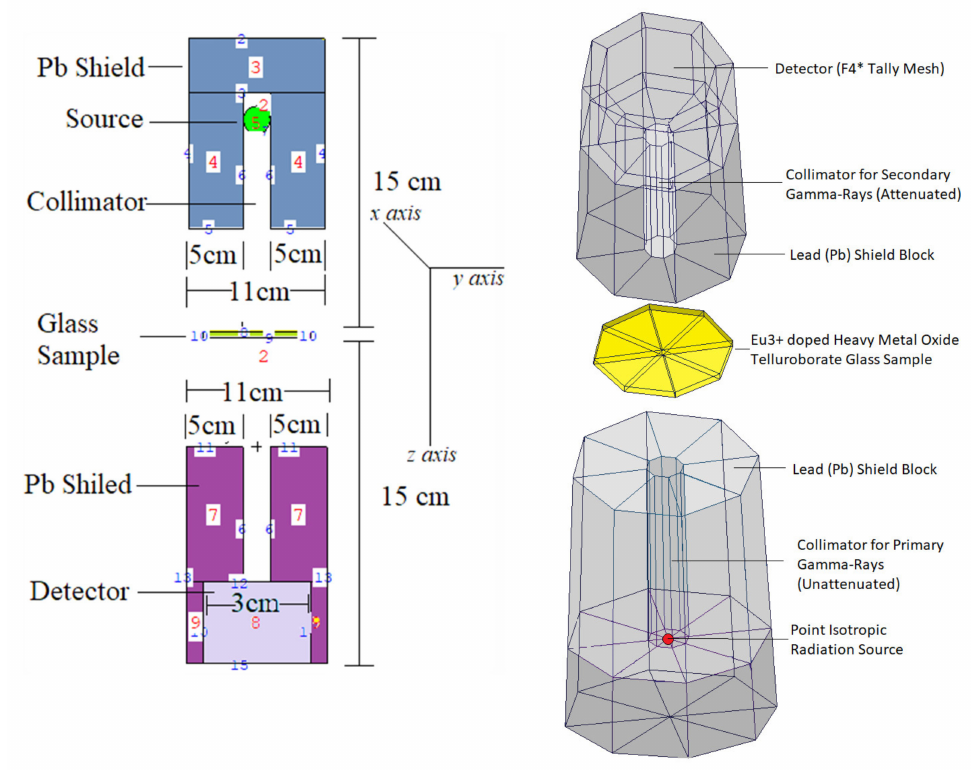
Figure 1. MCNPX simulation setup used for gamma-ray transmission simulations (A direct screen- shot from the MCNPX Visual Editor VE